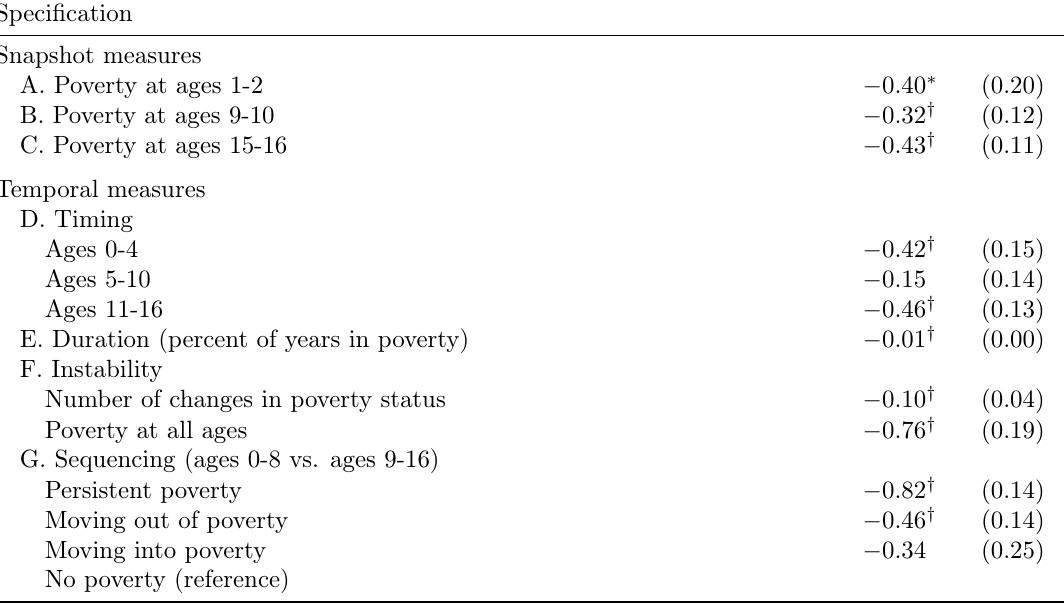
Table 7: Effect of Poverty on High School Graduation